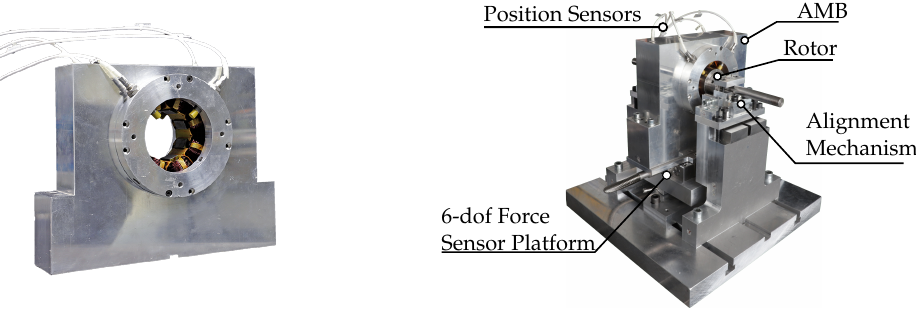
platform and temperature sensors to calibrate the simulation in relation to measured forces and Figure 9. Experimental setup to calibrate the simulation in relation to forces and temperatures.